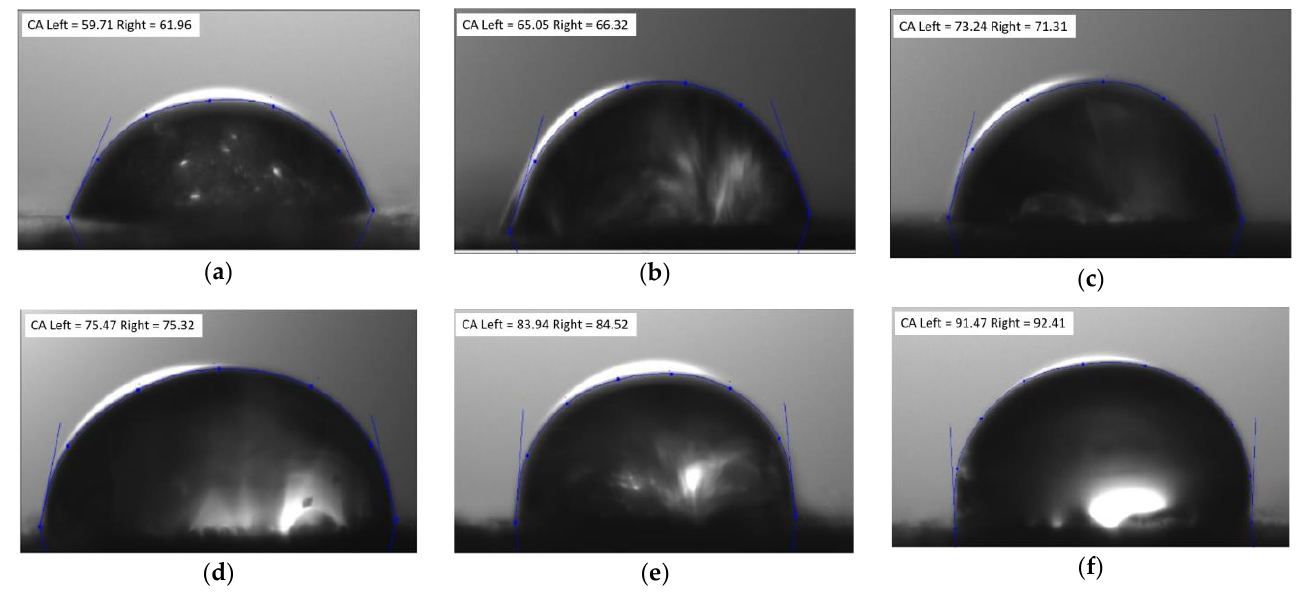
Figure 4. The droplet profile ’ s polynomial fit was achieved by using knots that go from the left to the right while accounting for the contact angle ( a ) B, ( b ) E, ( c ) B/E, ( d ) B/E/G5, ( e ) B/E/G10 and ( f ) B/E/G15.